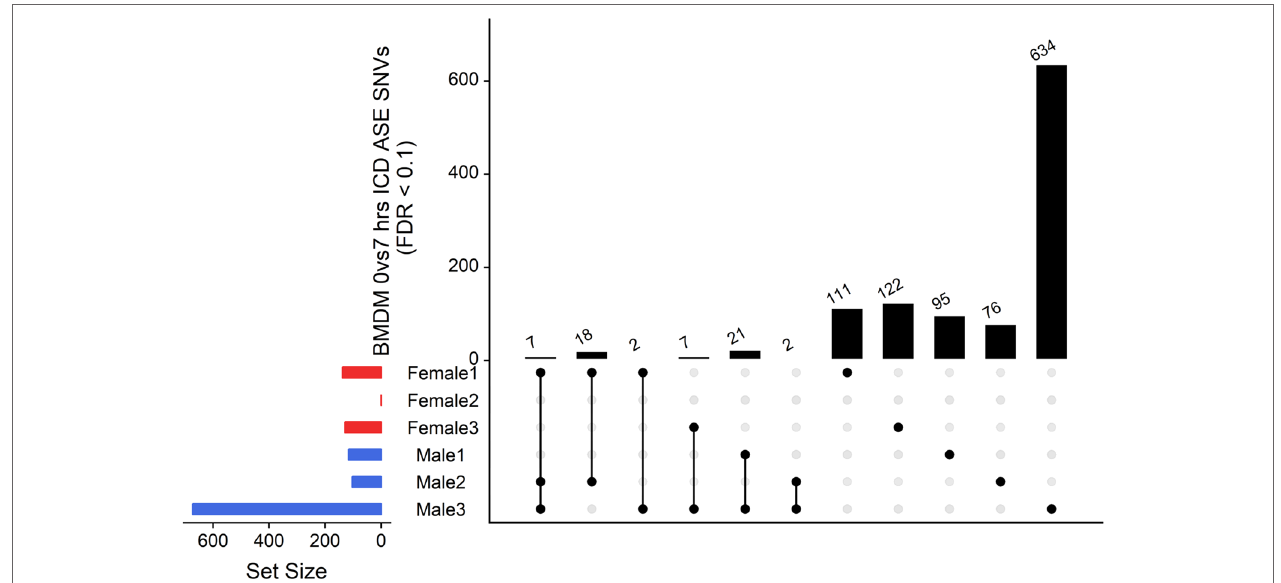
FIGURE 6 | Intersection analysis of SNVs under genes with significant ICD-ASE in the BMDMs ± LPS. From left to right, the set number of genes (dots connected by lines) has been illustrated in order according to the number of sheep sharing the SNV. The private sets of SNVs are located at the far right of each graph (single dots with no